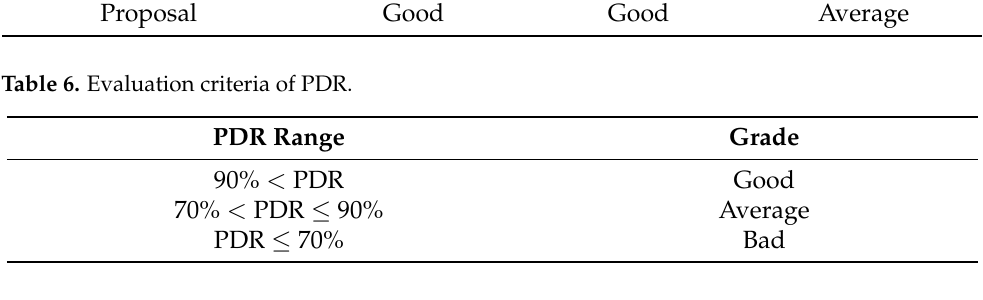
Table 7. Evaluation criteria of